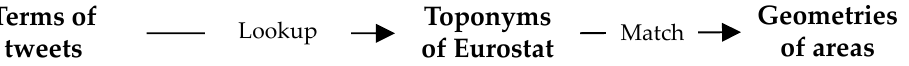
Figure 4. The geographical information of the investigated terms were assigned by matching toponyms of Eurostat’s